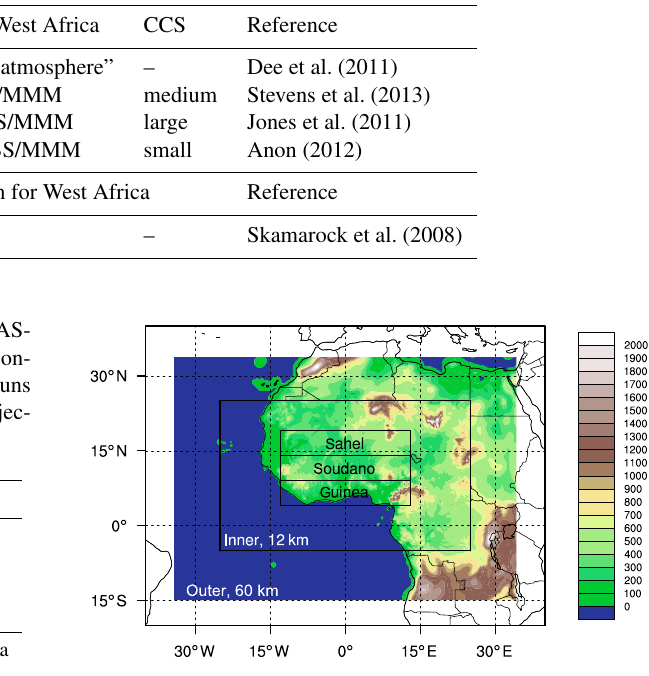
Figure 1. Nested domain configuration with 60 and 12km. Also shown are the three distinct regions used in the